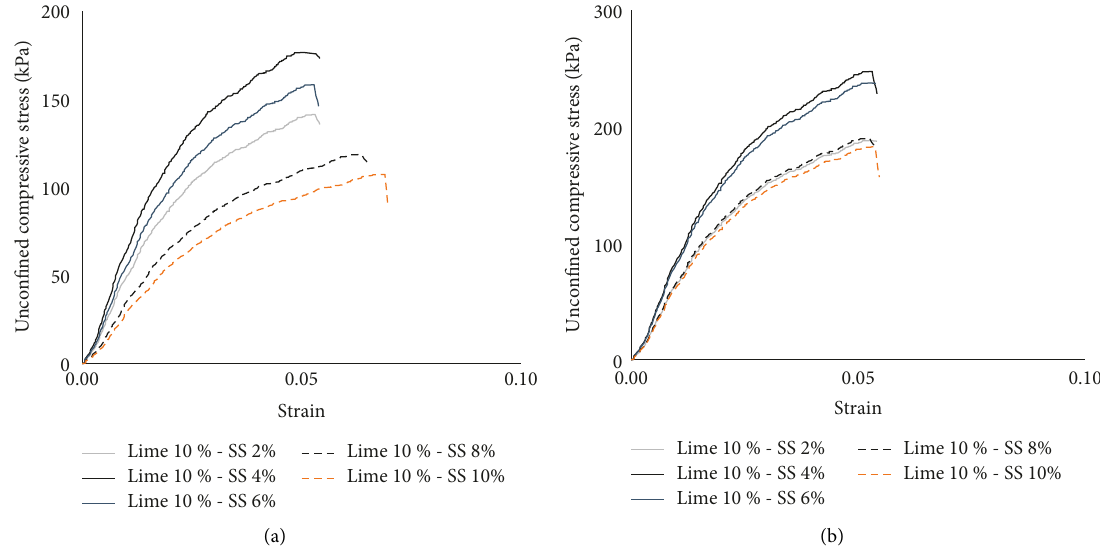
Figure 11: Results of the uniaxial pressure test of soil, 10% lime and different percentages of sodium silicate. (a) 7-day curing and (b) 28-day